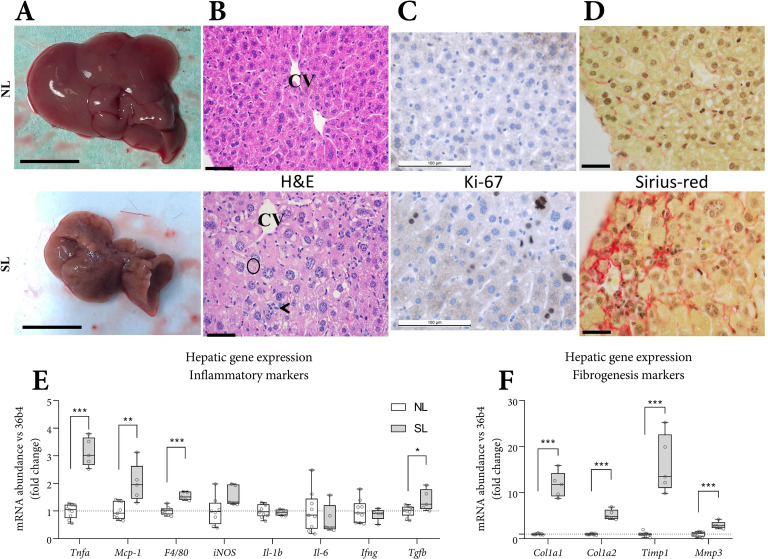
Liver morphology and histological analyses and gene expression markers of steatosis, inflammation, hepatocyte proliferation, and fibrosis.Gross liver appearance (most extreme, A, scale bars: 1 cm). Representative histological staining using hematoxylin and eosin (B, ‘H&E’), Ki-67 (C, proliferation marker) and Sirius-red (D, collagen fiber staining). Top row: NL, bottom row: SL. Hepatic gene expression for inflammatory (E) and fibrogenesis (F) markers. Histology scale bars: 50 μm. B: CV: central vein, circle: pigmented macrophage, arrowhead: mixed inflammatory cell infiltrate). Histological data represent the PN63 cohort. A-D: NL: n = 7, SL: n = 8. Gene expression data represent the pair-housed PN70 cohort. E-F: NL: n = 9, SL: n = 5. Data are shown as Tukey box plots and scatter plots. Exact two-sided Mann Whitey U test * p<0.05, ** p<0.01, *** p<0.001.